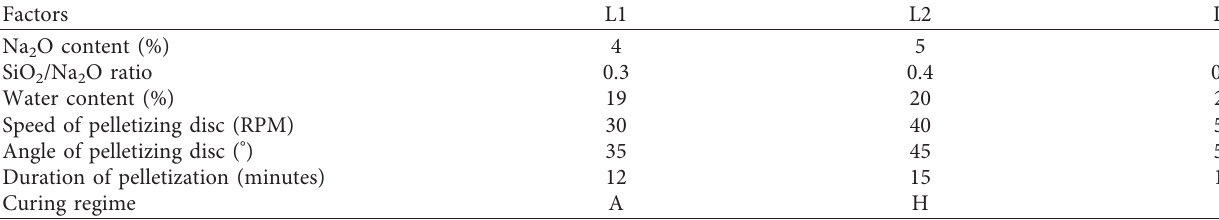
Table 2: Different individual factors and their values considered in the study.